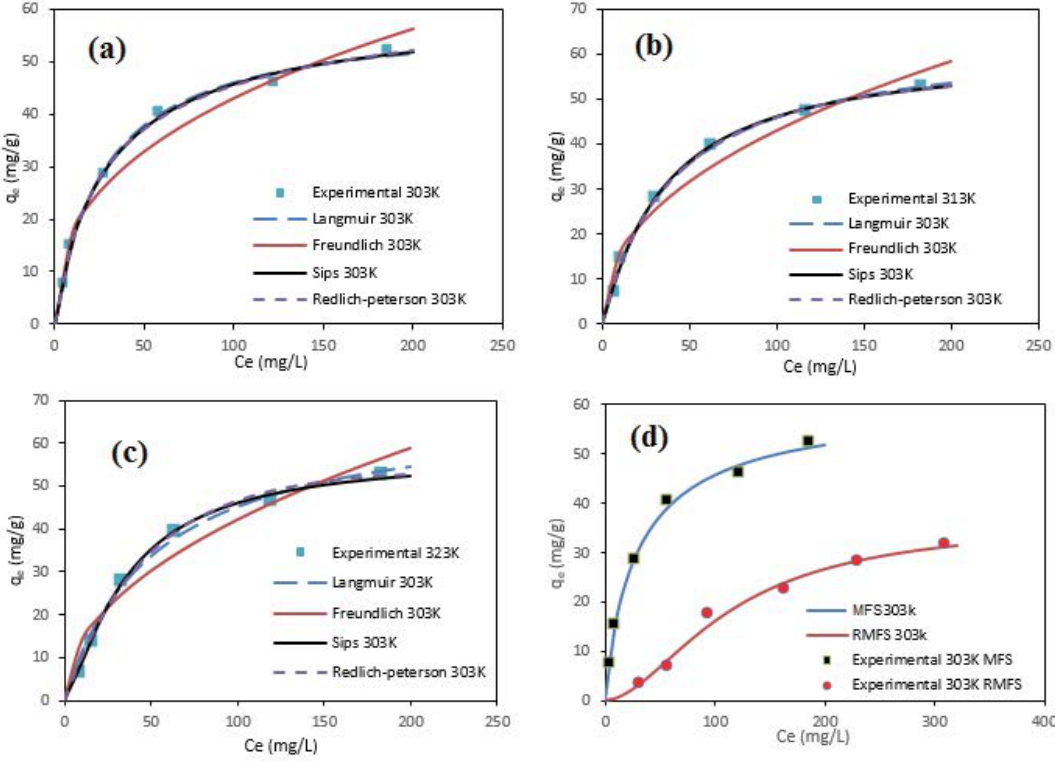
Fig. 11. Isotherm plots for MB adsorption onto MFS at (a) 303 K, (b) 313 K, (c) 323 K, and (d) Sips adsorption isotherm for MFS and RMFS at 303K.